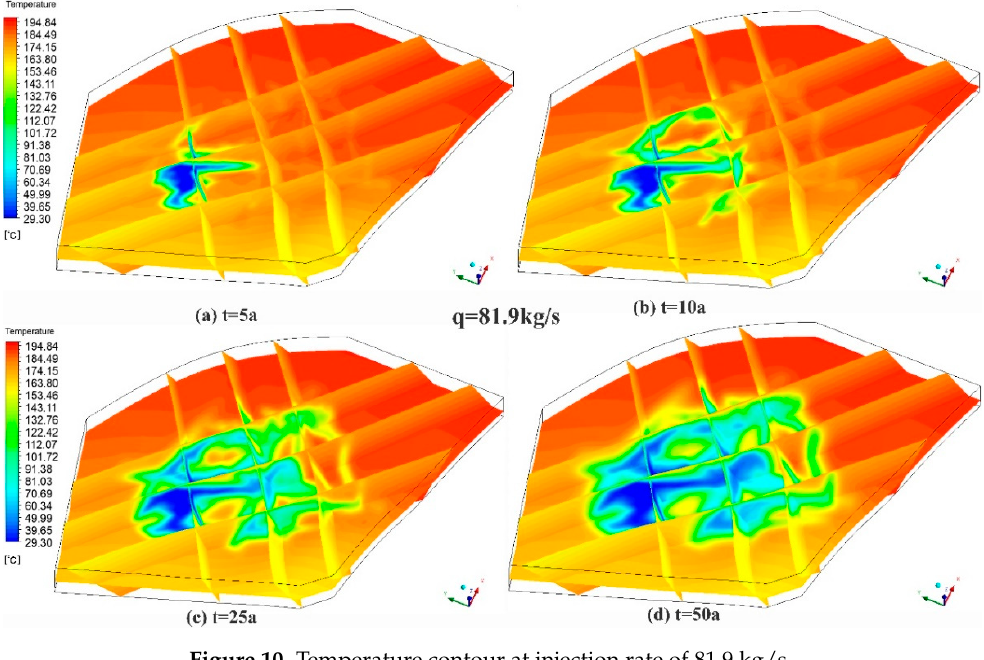
Figure 10. Temperature contour at injection rate of 81.9 kg/s.